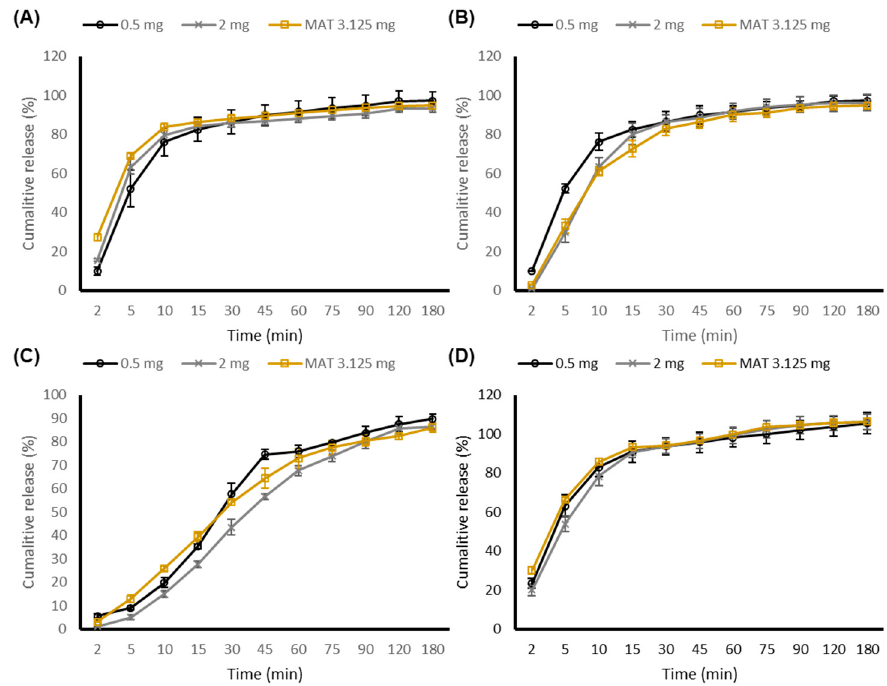
Figure 4. Dissolution profile comparison between carvedilol 0.5 mg ODMT, 2 mg ODMT, and mar- keted 3.125 mg tablet in adult and paediatric biorelevant media. Data presented as mean ± standard deviation ( n = 6). MAT = Marketed adult tablet. ( A ) FaSSGF, ( B ) FeSSGF, ( C ) FaSSIF-V2, and ( D ) FeSSIF-V2.